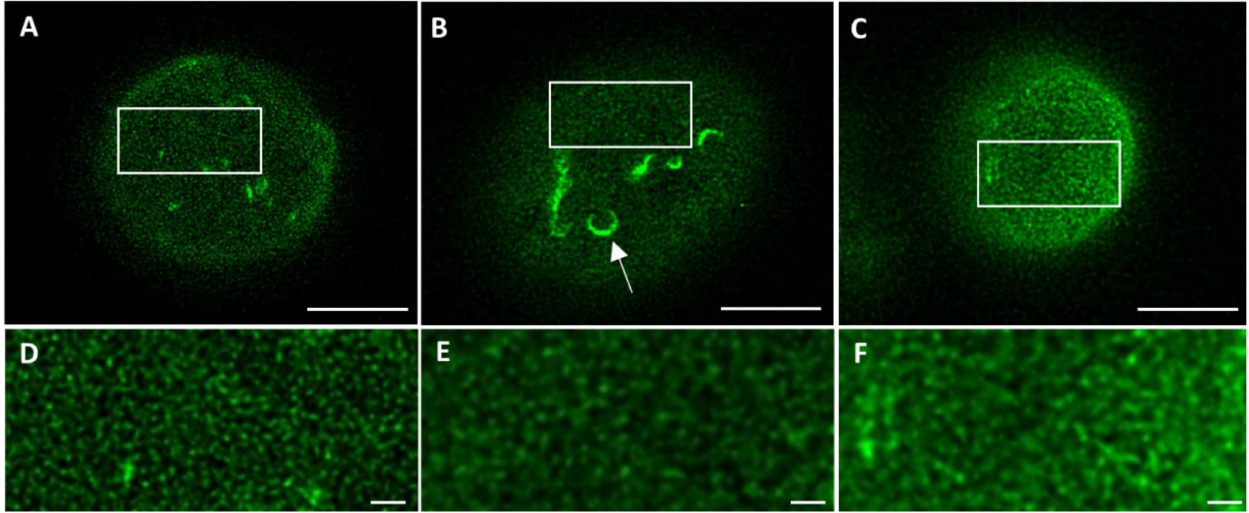
Figure 2. STED microscopy images of the top of the nucleus from ( A ) non-fixed live lam-B1-EGFP transfected 3T3 cells, ( B ) fixed lam-B1-EGFP transfected 3T3 cells, and ( C ) fixed 3T3 cells stained with antibodies against lamin B1. ( D – F ) Higher magnification (2.9 × ) of ROIs (white rectangles) indicated in ( A – C ), respectively. Arrow in B indicates structures of the nucleoplasmic reticulum. Scale bars: 5 µ